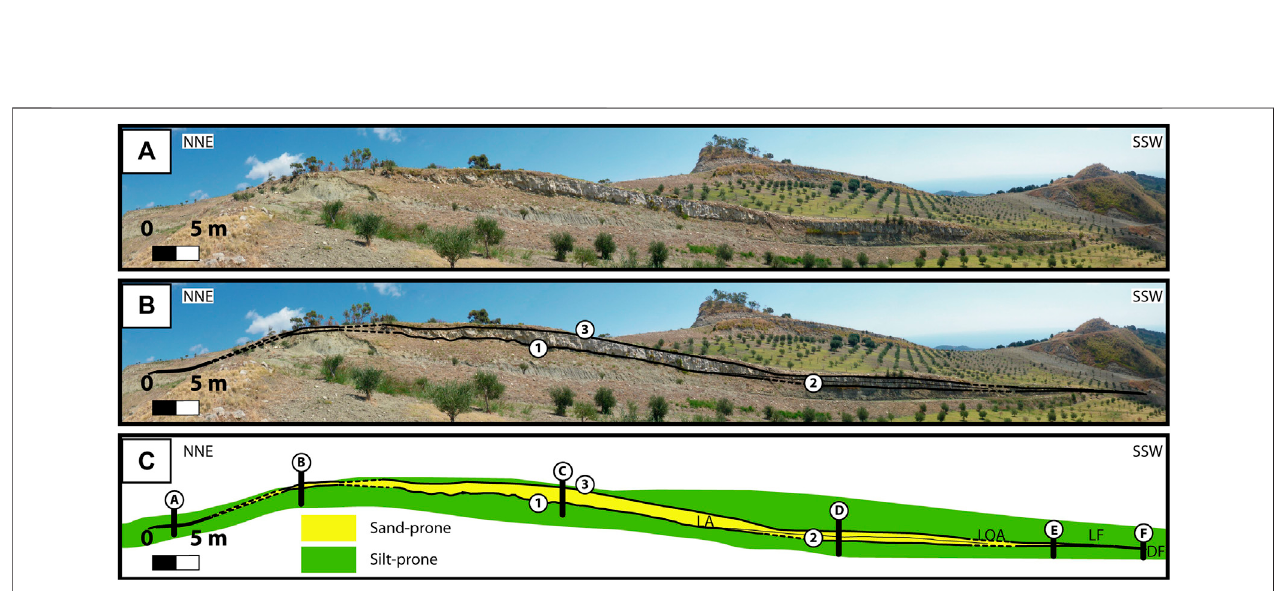
Frontiers in Earth Science |